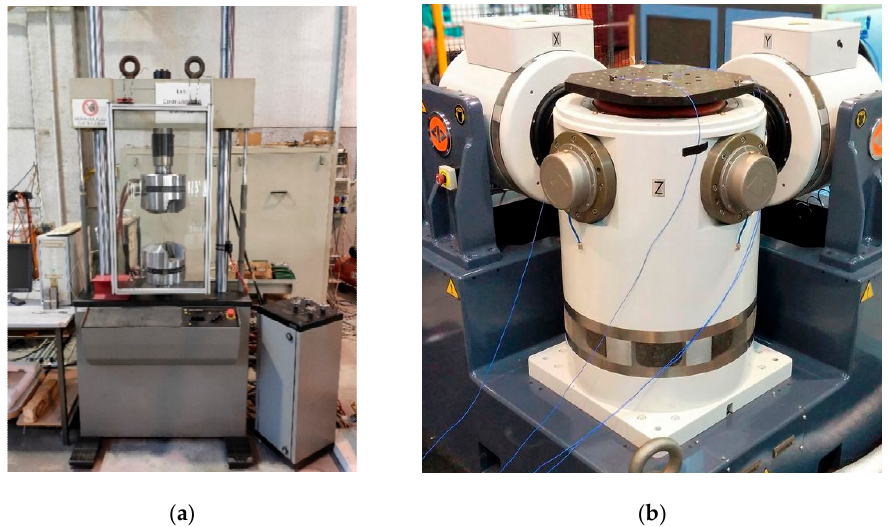
Figure 4. Testing machines adopted in mechanical laboratories: ( a ) servo-hydraulic; ( b ) electrodynamic shaker table.